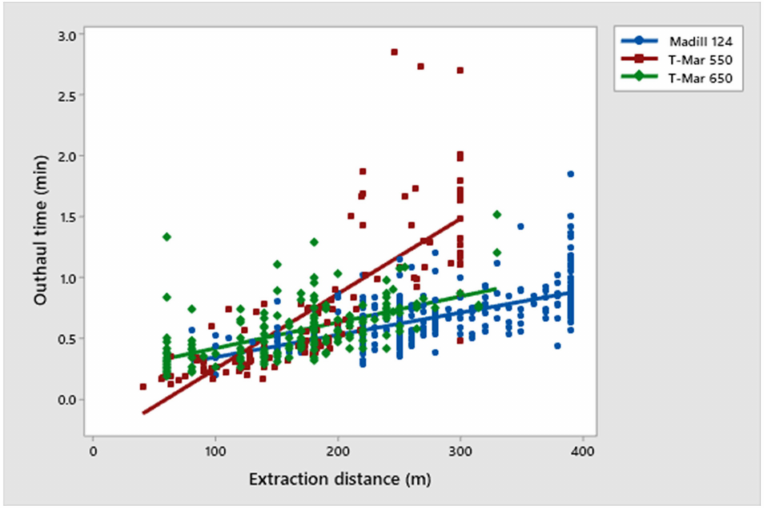
Figure 2. Relationship between outhaul and extraction distance for the three swing yarders studied.